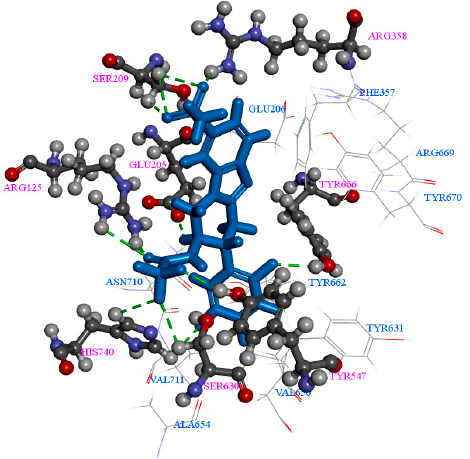
Figure 9. Intermolecular interactions of 2P8S_Comp70 during MD simulation. 12 H-bond collaborations are denoted as dotted lines. Amino acids displayed in this figure are all active site residues. The Arg125, Glu205, Ser209, Arg358, Tyr547, Ser630, Tyr666, and His740 participate in H-bonding; there are two H-bonds from Arg125, one H-bond from Glu205, three H-bonds from Ser209, one H-bond from Arg358, one H-bond from Tyr547, one H-bond from Ser630, one H-bond from Tyr666, and two H-bonds from His740.